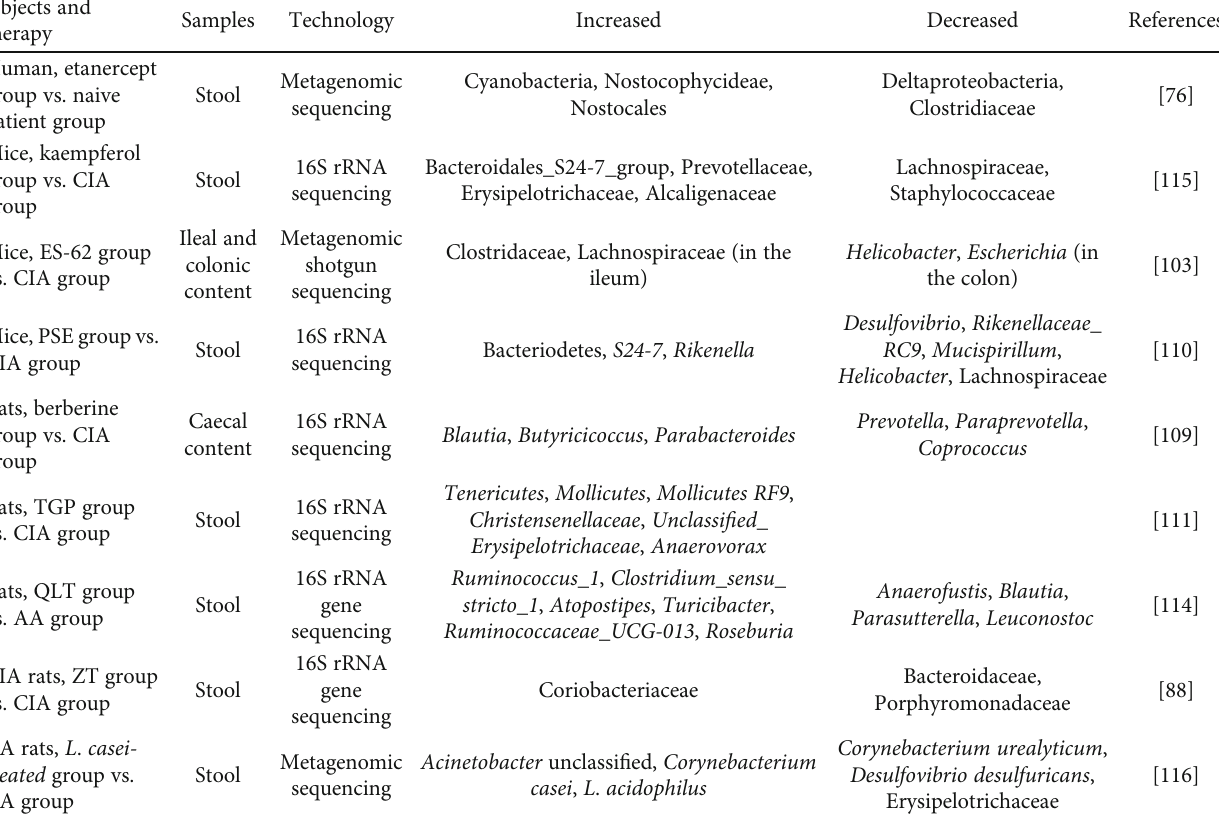
Table 2: The partial restoration of the gut microbiota in the treatment of